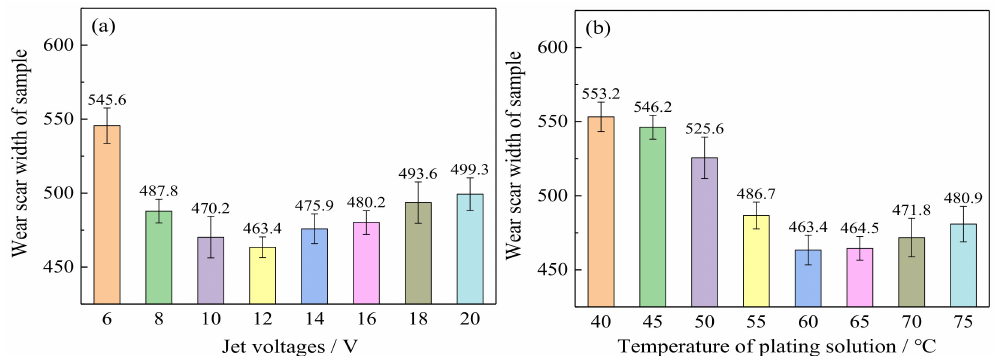
Figure 8. Wear resistance of Ni–Co–P alloy coatings as a function of varying: ( a ) jet voltages; ( b ) temperature of plating